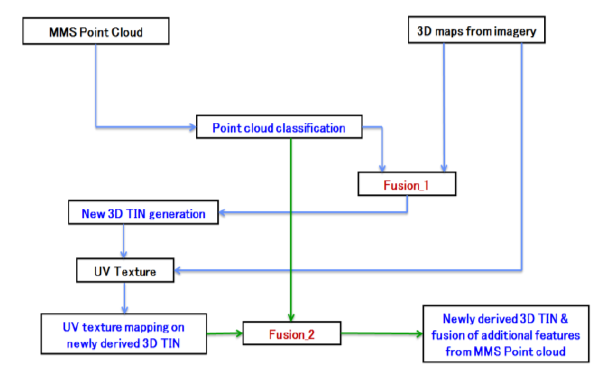
Figure 2. Data integration